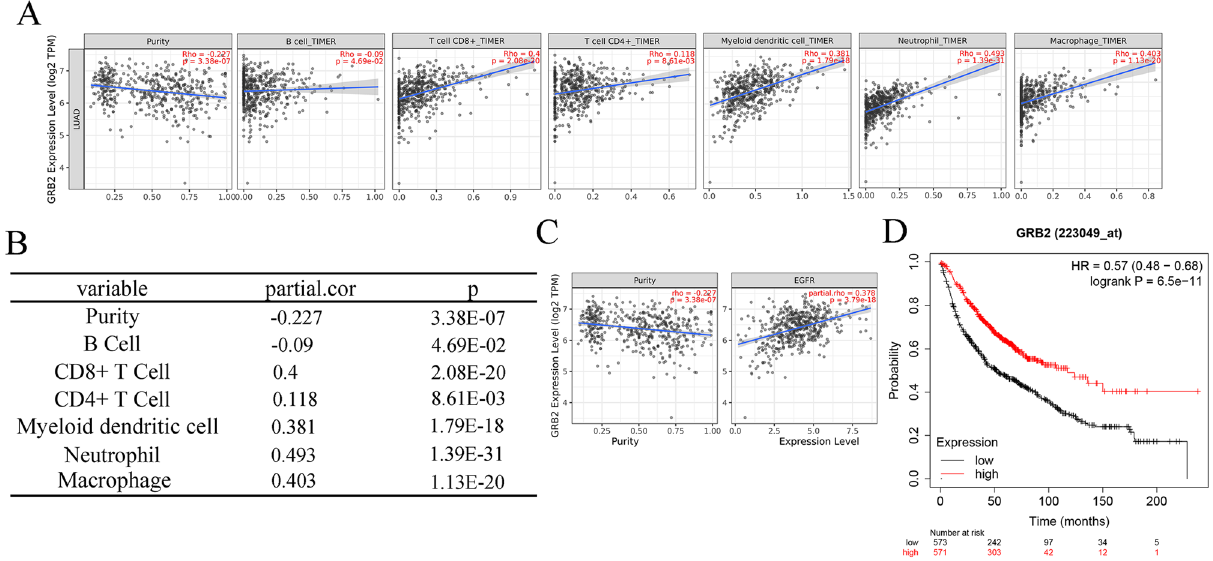
Figure 11. The expression of GRB2 and immune infiltrates in LUAD. ( A , B ) Correlation of GRB2 expression with immune infiltration level in LUAD. GBR2 expression had significant positive correlations with infiltrating levels of CD8 + T cells, CD4 + T cells, macrophages, neutrophils and myeloid dendritic cells. ( C ) Relationship between GRB2 and EGFR in LUAD. GRB2 expression showed a strong correlation with EGFR expression after adjusting tumor purity in LUAD. ( D ) Prognostic values of GRB2 (n = 2437) in LUAD (OS in Kaplan–Meier plotter). Line in red with high expression while in black with low expression. Low expression of GRB2 was connected with better over